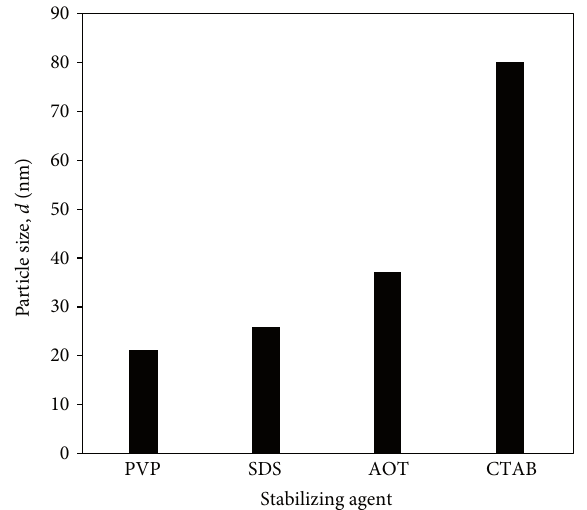
/RuCl MR on particle size using 4